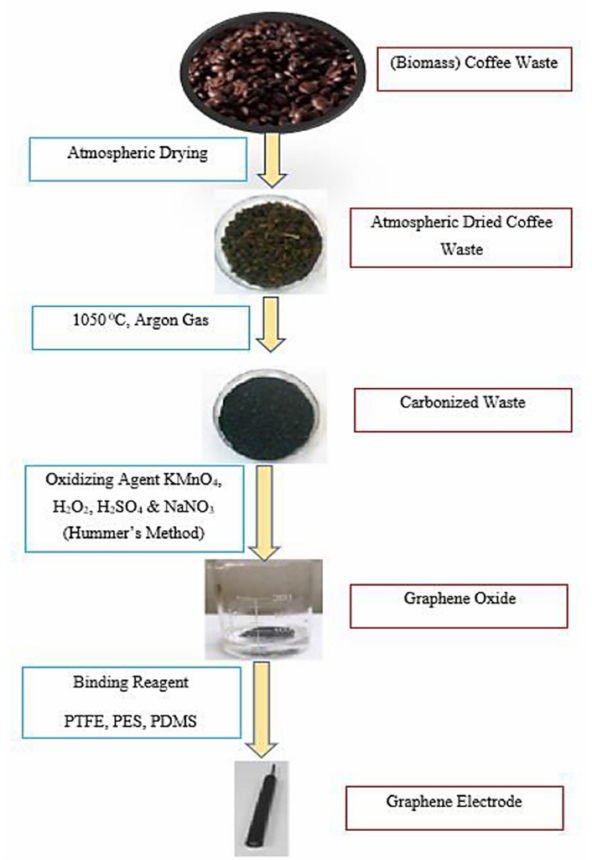
Figure 2. Schematic diagram of advanced Hummer’s method for graphene oxide